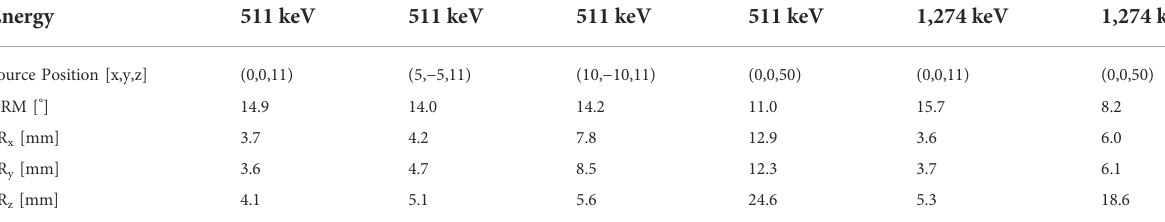
TABLE 1 Summary of the performance characterization (FWHM values) of the Compton camera.